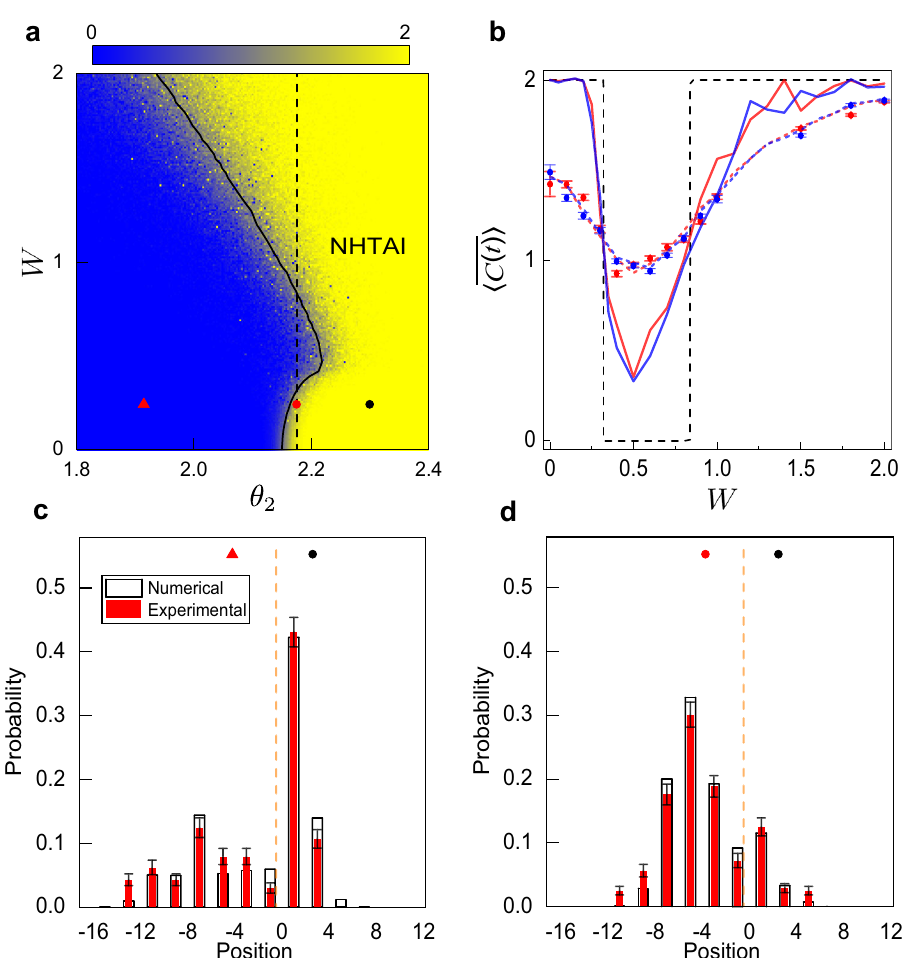
Fig. 4 Characterizing topology. a Theoretical phase diagram in terms of the color contour of the numerically evaluated biorthogonal local marker, with θ = 4.3 + δθ ( x ), and γ = 0.1. The yellow (blue) region corresponds to the topologically non-trivial (trivial) phase, thus the non-Hermitian topological 1 Anderson insulator state corresponds to the yellow region with W > 0 (labeled NHTAI in a ). b Measured averaged chiral displacement for 9-step quantum walks with θ 2 = 2.175 (vertical dashed line in a ), averaged over ten different con fi gurations of δθ ( x ), with δθ ( x ) taking random values within the range (cid:2) W ; W ½ (cid:4) . Experimental data were represented by blue and red dots for γ = 0 and γ = 0.1, respectively. Error bars are due to the statistical uncertainty in photon-number-counting. Blue and red dashed lines are numerically evaluated chiral displacements for nine-step quantum walks, averaged over 2000 random-disorder con fi gurations, for γ = 0 and γ = 0.1, respectively. Blue and red solid lines are numerically evaluated chiral displacement for 400-step quantum walks, averaged over 200 random-disorder con fi gurations, for γ = 0 and γ = 0.1, respectively. For all cases, the initial state is 0 j i (cid:3) V j i . c , d are the measured probability distributions after the last time step of ten-step quantum walks close to a boundary (indicated by the vertical dashed lines). In c , we set θ 2 = 1.915 for x ≤ − 1 (red triangle in a ), and θ 2 = 2.3 for x ≥ 0 (black dot in a ). In d , θ 2 = 2.175 for x ≤ − 1 (red dot in a ), and θ 2 = 2.3 for x ≥ 0 (black dot in a ). In c , d , red (black) bars correspond to experimental measurements (numerical simulations), both averaged over ten disorder con fi gurations. The walker is initialized at 1 j i (cid:3) V j i , and we fi x W =